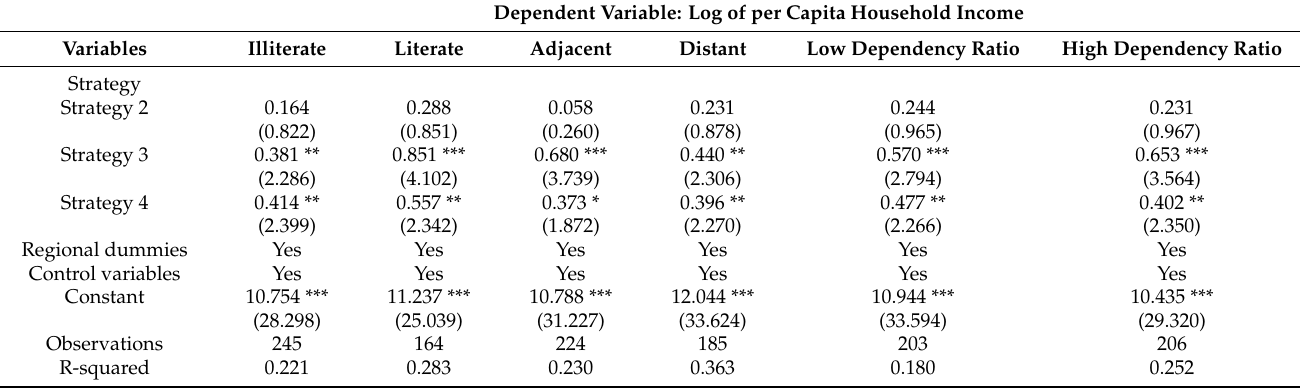
Table 6. Heterogeneities in the association between livelihood strategies and household income. Dependent Variable: Log of per Capita Household